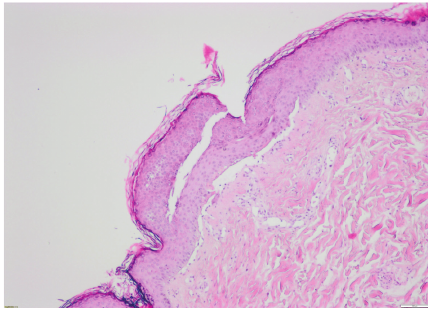
Figure 2: Biopsy of blister showing neutrophils within the blister cavity (haematoxylin and eosin, original magnification × 40).